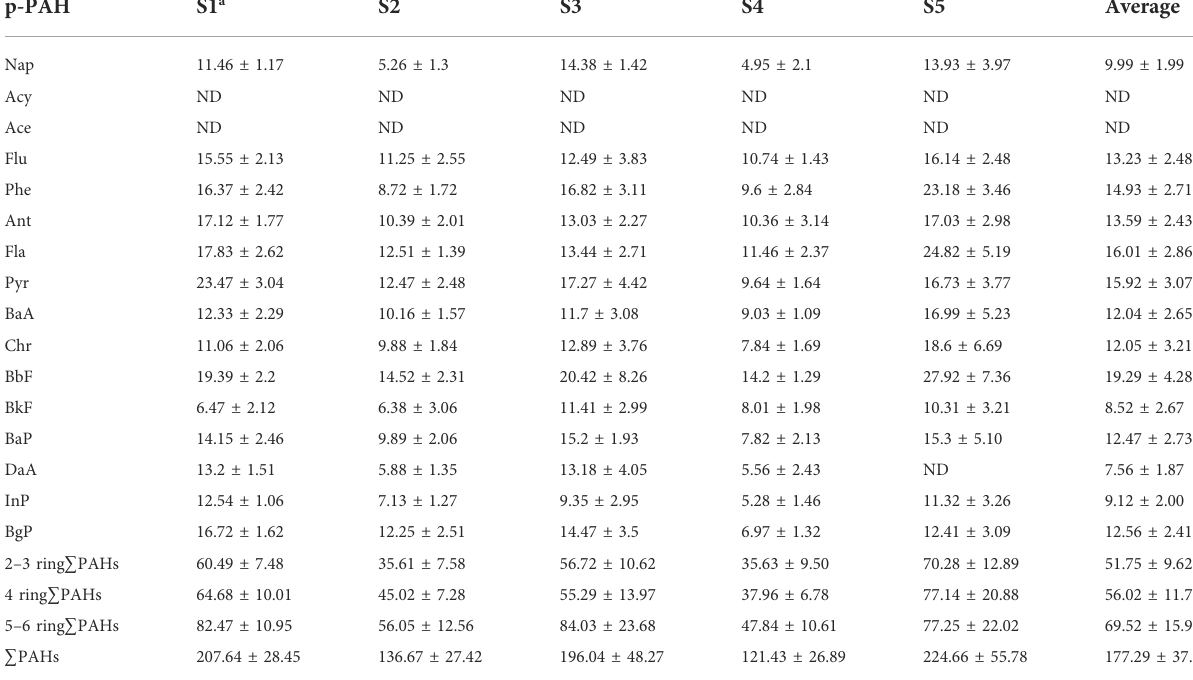
TABLE 2 Concentration of (cid:1) 16 p-PAHs in samples of soil